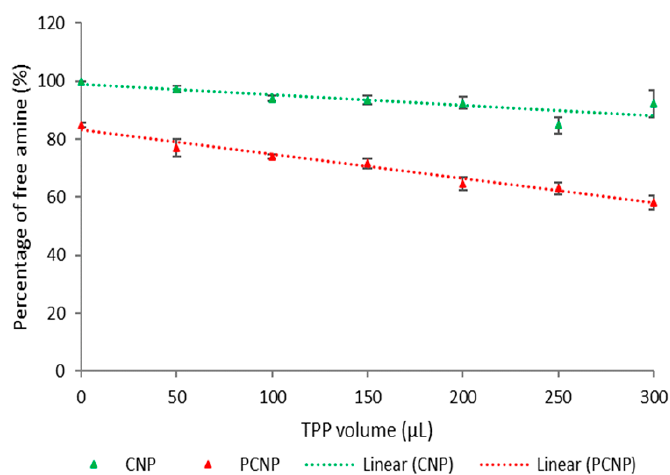
Figure 3. Percentage of free amine content in chitosan before (CNP) and after (PCNP) modification across a range of TPP volume. The free amine content in PCNP was lesser than in CNP. The loss of primary amine in CNP was due to the conjugation of palmitic acid during modification.